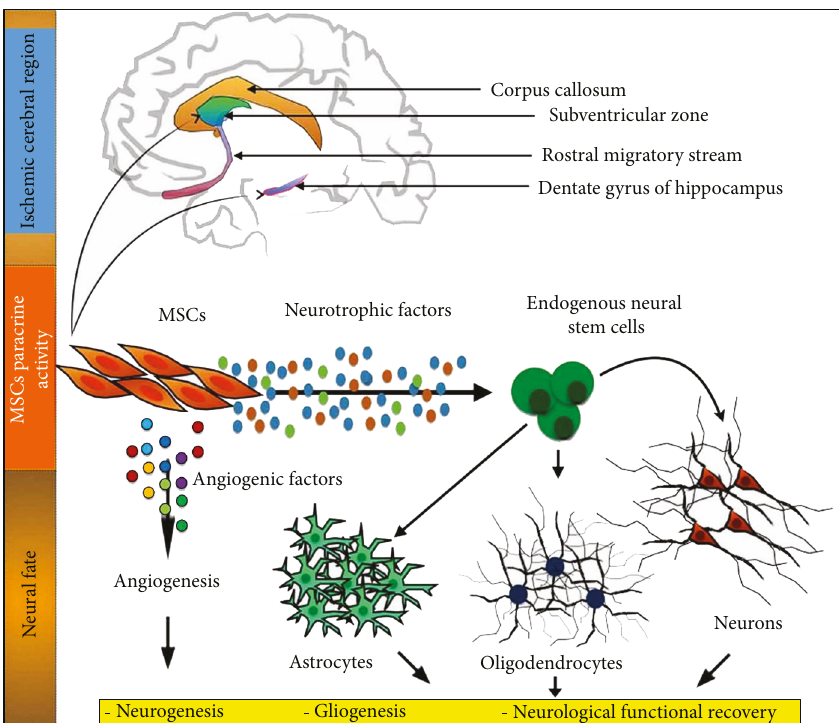
Figure 3: Implantation of hMSCs may repair damaged neural cells induced by stroke through the paracrine mechanisms. hMSCs can secrete various angiogenic and neurotrophic factors to support endogenous angiogenesis, neurogenesis, and gliogenesis, leading to improved neurological function in ischemic stroke models. This image is adapted from [109] published under the Creative Common Attribution